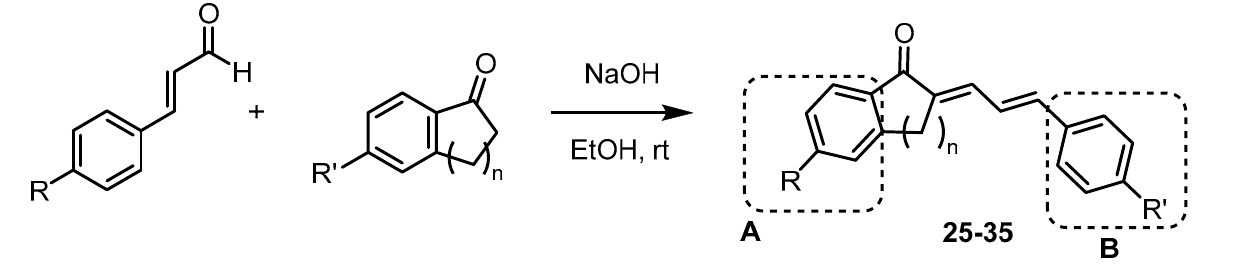
Scheme 3. Synthesis of extended chalcone derivatives ( 25–35 ).